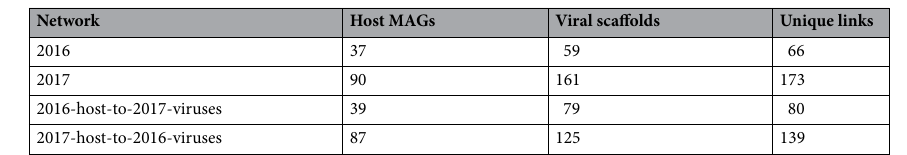
Table 2. Virus-host networks summary. Virus-host interactions are based on host MAG CRISPR spacers and viral element protospacer connections. Unique links = 1 MAG to 1 viral element, regardless of number of spacer